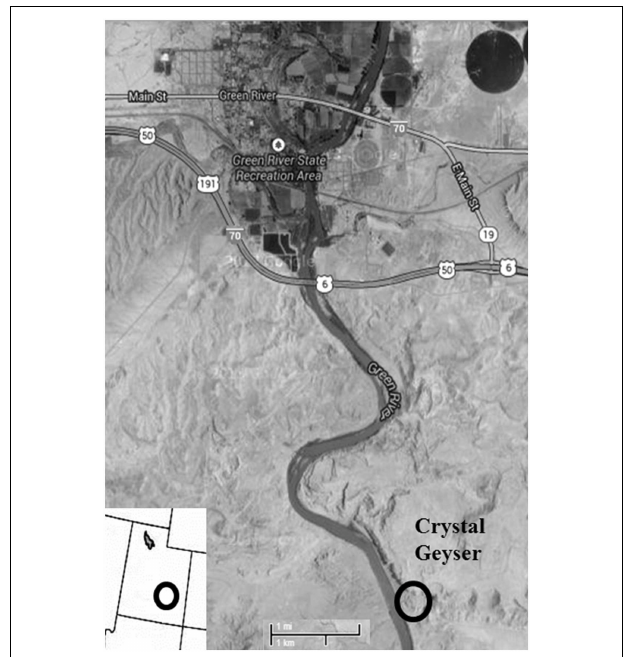
FIGURE 1 | Location of Crystal Geyser, adapted from Google